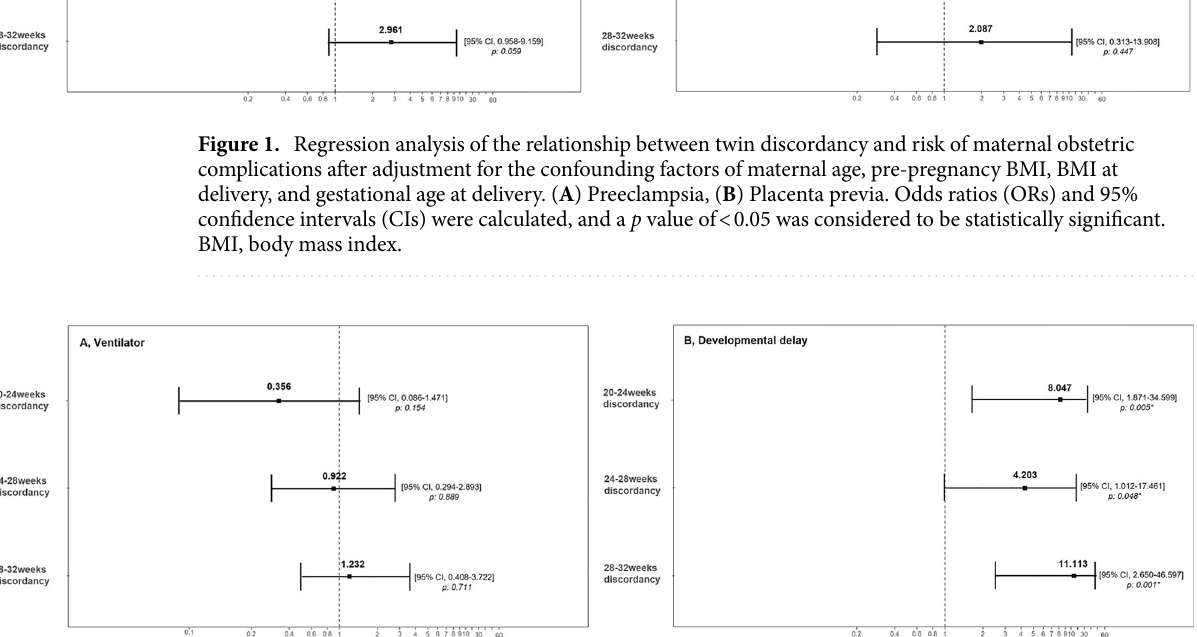
Figure 2. Regression analysis of the relationship between twin discordancy and risk of neonatal outcomes after adjustment for the confounding factors of neonatal birth weight, gestational age at delivery, and NICU admission. ( A ) Intubation, ( B ) Developmental delay. Odds ratios (ORs) and 95% confidence intervals (CIs) were calculated and a p value of < 0.05 was considered to be statistically significant. NICU, neonatal intensive care